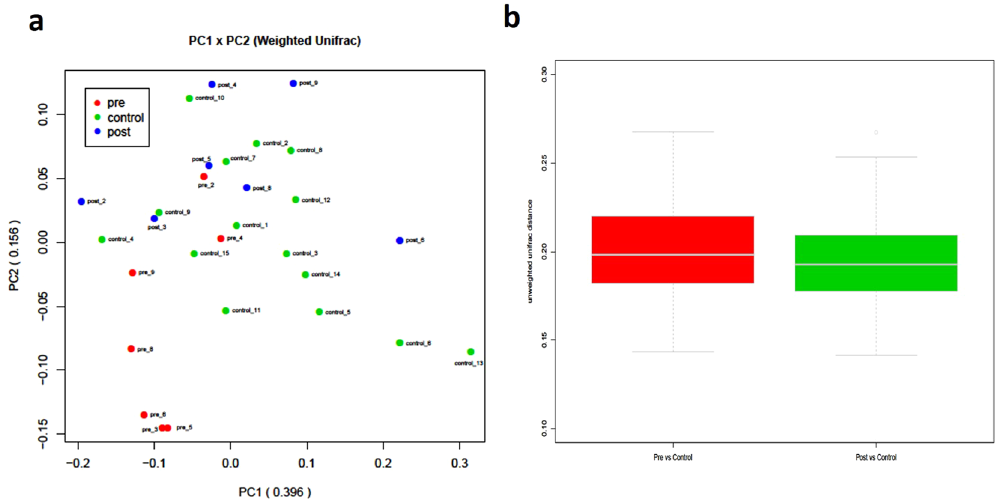
Figure 1. The results of a PCoA based on OTU composition are shown as graphs of the ( a ) LT-filtered weighted unifrac distance and ( b ) the unifrac distance from the pre-LT and post-LT samples to the control